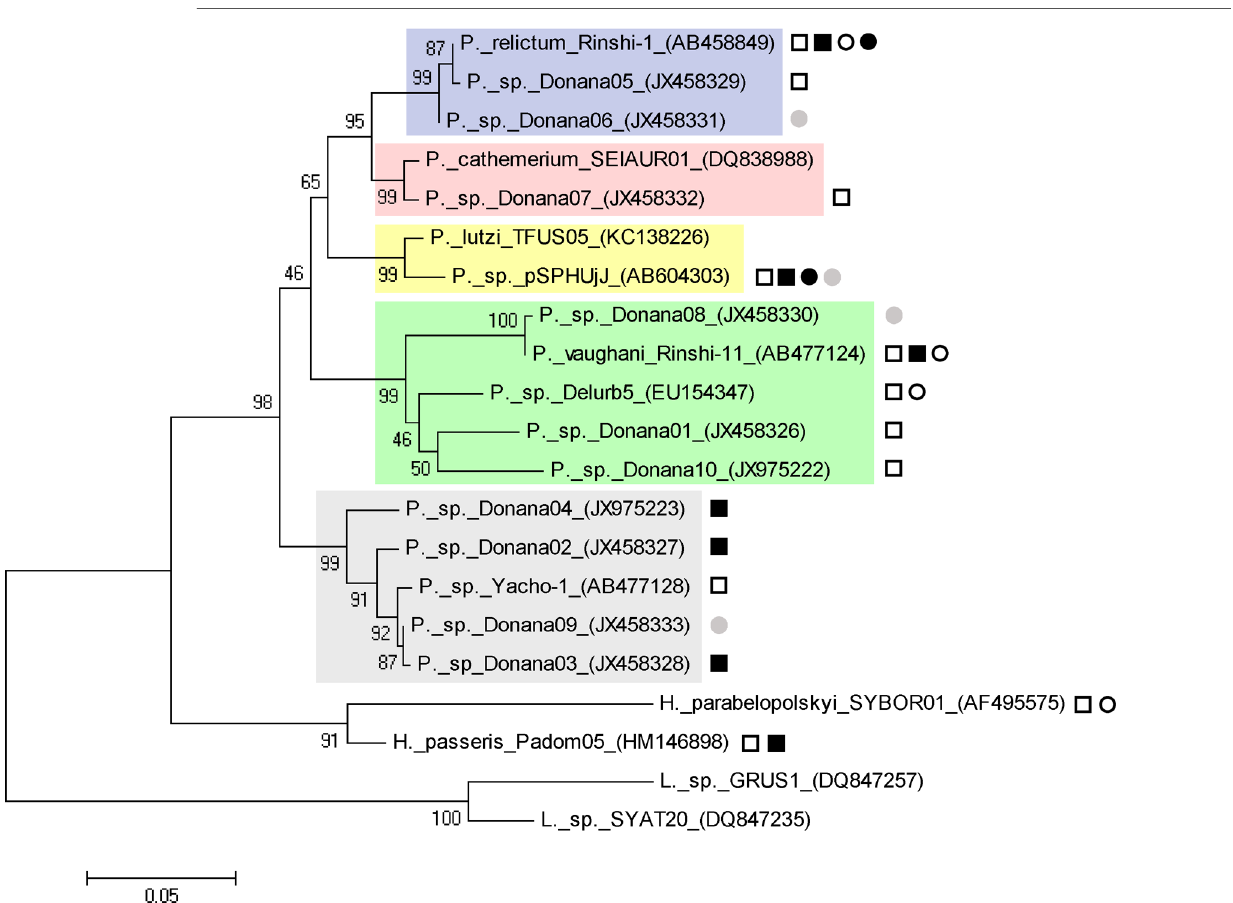
Figure 2. Phylogenetic relationships of Plasmodium and Haemoproteus lineages obtained in the current study based on cytochrome b sequences of 478 bp. Similar sequences from samples identified to morphospecies level available in GenBank and MalAvi were included for reference. Leucocytozoon GRUS1 and SYAT20 lineages were used as out-groups. The numbers on the top of the branches indicate bootstrap support (10 000 replications). The mosquito species infected by each parasite are represented as follows: Cx. pipiens (black circle); Cx . theileri (white circle); Oc . caspius (grey circle); Cx . modestus (black square); Cx . perexiguus (white square).